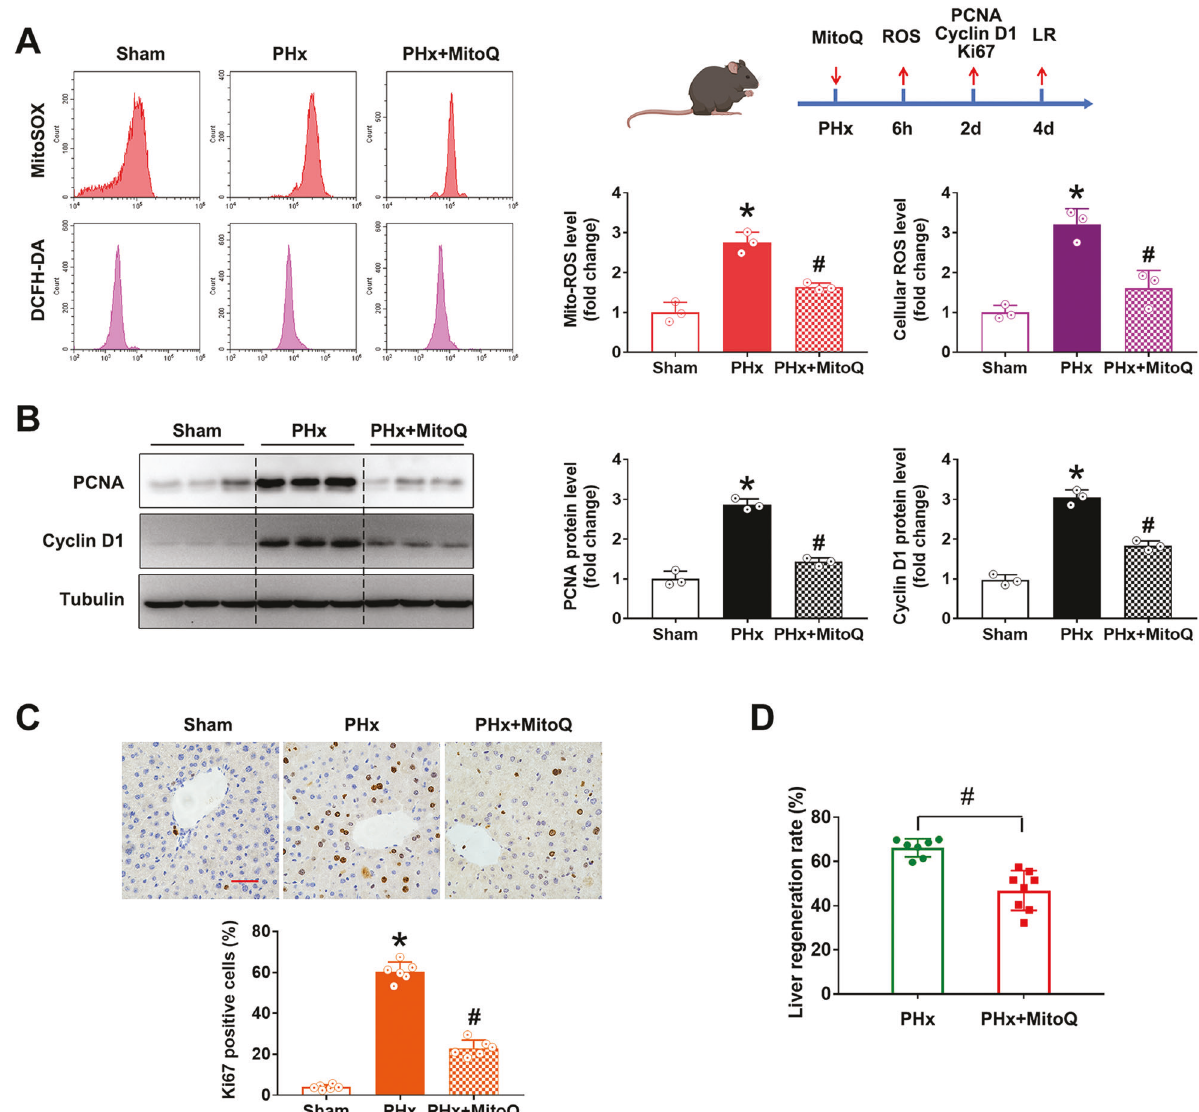
Fig. 2 The mitochondrial-targeted antioxidant MitoQ inhibited LR after PHx in mice. The C57 mice were intraperitoneally injected with MitoQ (2 mg/kg BW) immediately after PHx and followed once daily. The ROS production was detected at 6 hours, and LR was determined on the 2th day after PHx. A Schematic representation of the experimental procedure and fl ow cytometry assay and quanti fi cation of cellular ROS (probed with DCFH-DA) and mitochondrial ROS (probed with MitoSOX) (three independent experiments). B Western blot analysis and quanti fi cation of PCNA and Cyclin D1 (three independent experiments). C Immunohistochemistry staining and quanti fi cation of Ki67, bar = 50 µm, n = 6. D LR rate, n = 7. Data are shown as means ± SEM. * P < 0.05 vs Sham group and # P < 0.05 vs PHx